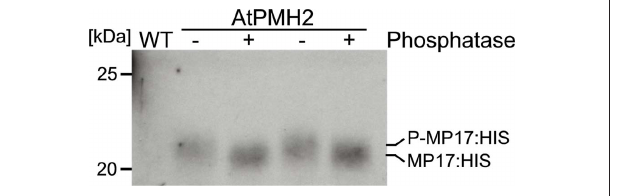
FiguRe 5 | Treatment of MP17:HiS with λ -Phosphatase. Purified MP17:HIS was incubated with ( + ) or without ( − ) λ -Phosphatase and gel migration was monitored by SDS-PAGE following immunological detection of MP17:HIS; probes are duplicates; WT, wild type crude extract.